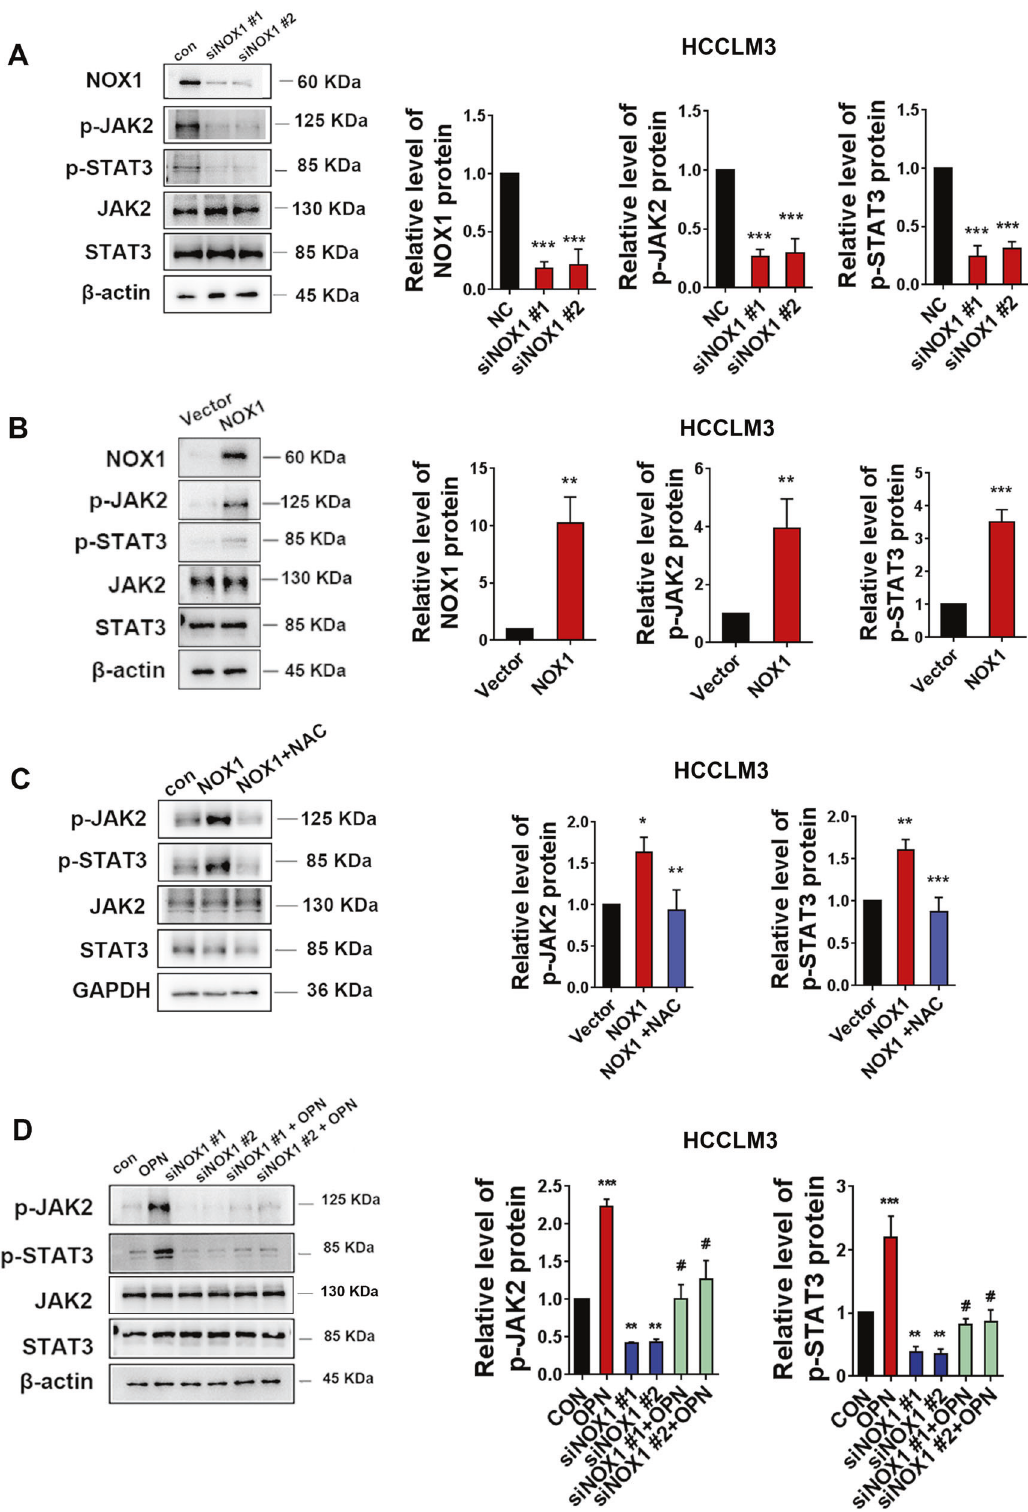
Fig. 6 NOX1-induced ROS stimulates JAK2/STAT3 pathway and ampli fi es the effect of JAK2/STAT3 by OPN in HCCLM3 cells. HCCLM3 cells were transfected with siNOX1 or negative control. A Western blot analysis of NOX1, pJAK2, and pSTAT3 expressions was performed after transfection. The levels of NOX1, pJAK2, and pSTAT3 proteins were analyzed after transfection with NOX1 overexpression plasmid or vector control ( B ). The levels of pJAK2 and pSTAT3 proteins were analyzed in NOX1 overexpressed HCCLM3 cells and NAC treated NOX1 overexpressed HCCLM3 cells ( C ). Western blot analysis was carried out for the levels of pJAK2 and pSTAT3 proteins of control HCCLM3 cell, hOPN treated HCCLM3 cells, siNOX1 HCCLM3 cells, and siNOX1 HCCLM3 cells treated with hOPN ( D ). Data indicated mean ± SD. n = 3, * P < 0.05, ** P < 0.01, *** P < 0.001, # Compared with NOX1 overexpression or hOPN treatment.